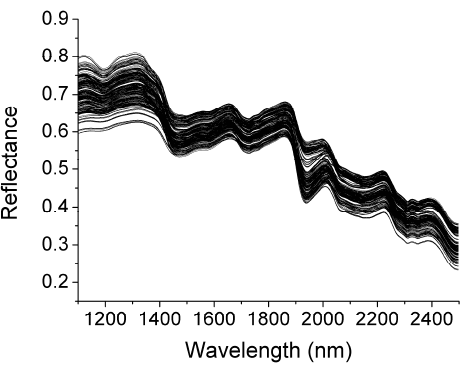
Figure 1. Raw reflectance spectra of oilseed rape leaves.